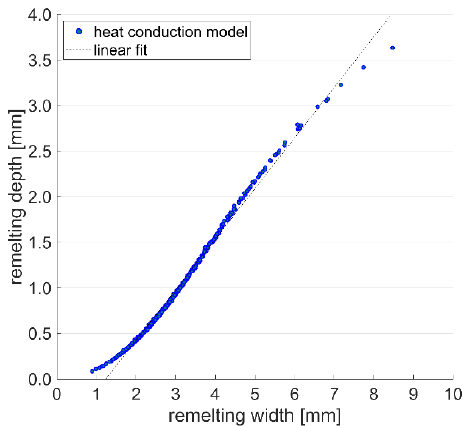
Figure 8. Correlation of remelting width and depth for the simulation results of the heat conduction model with the fit, according to Equation (10).